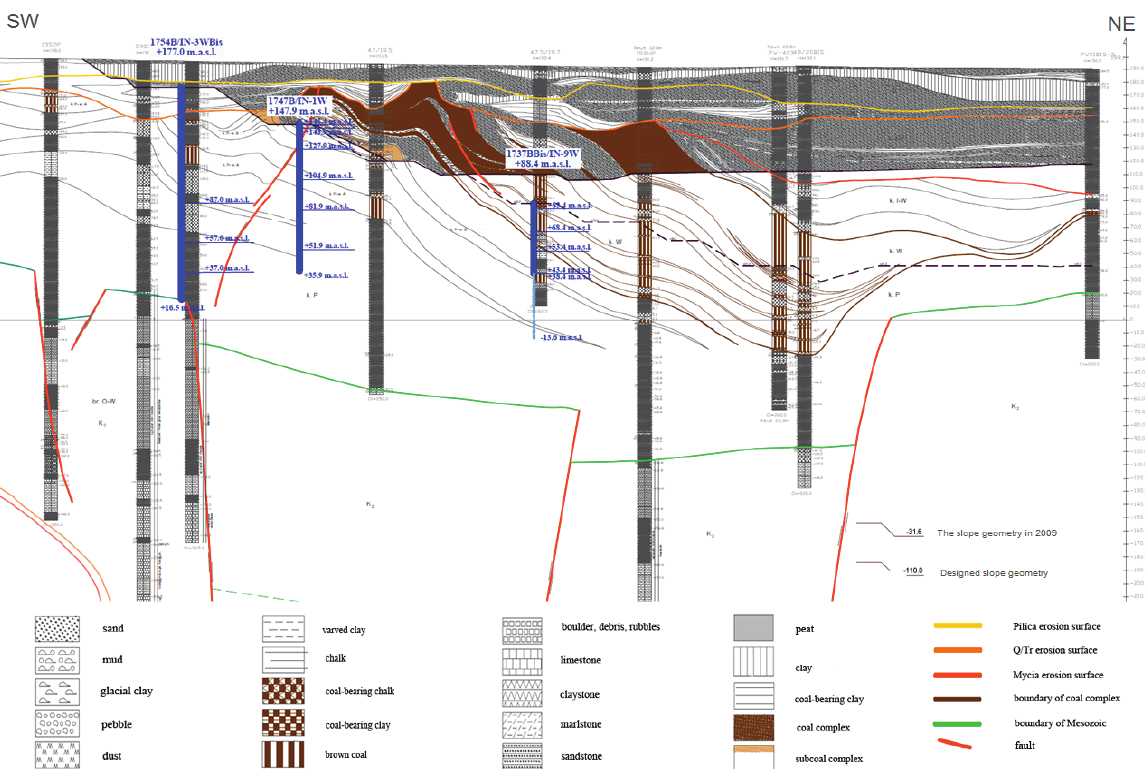
Fig. 6. The Ib’ geological cross-section of the Bełchatów western slope with the location of the inclinometers No.: 1754B/IN-3WBis, 1747B/IN-1W, 1737BBis/IN-9W (based on